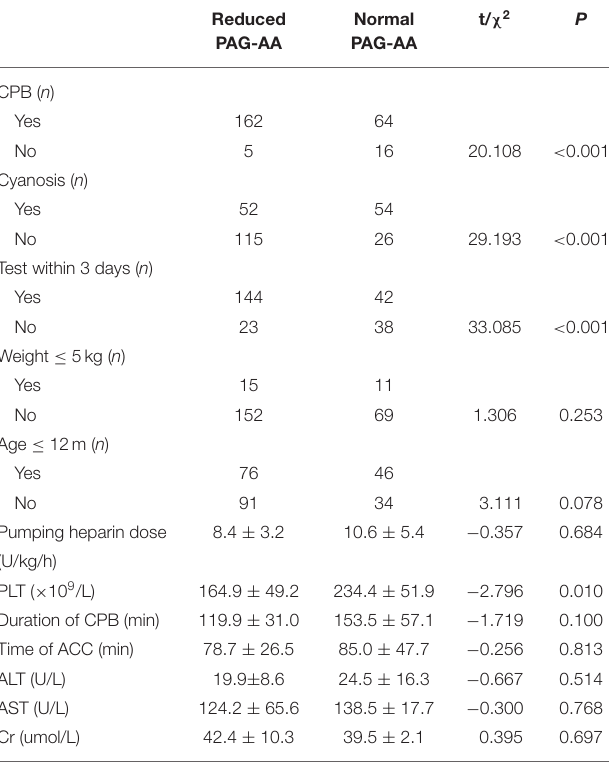
TABLE 2 | Univariate analysis for decreased basal arachidonic acid-induced platelet aggregation (PAG-AA). Reduced PAG-AA